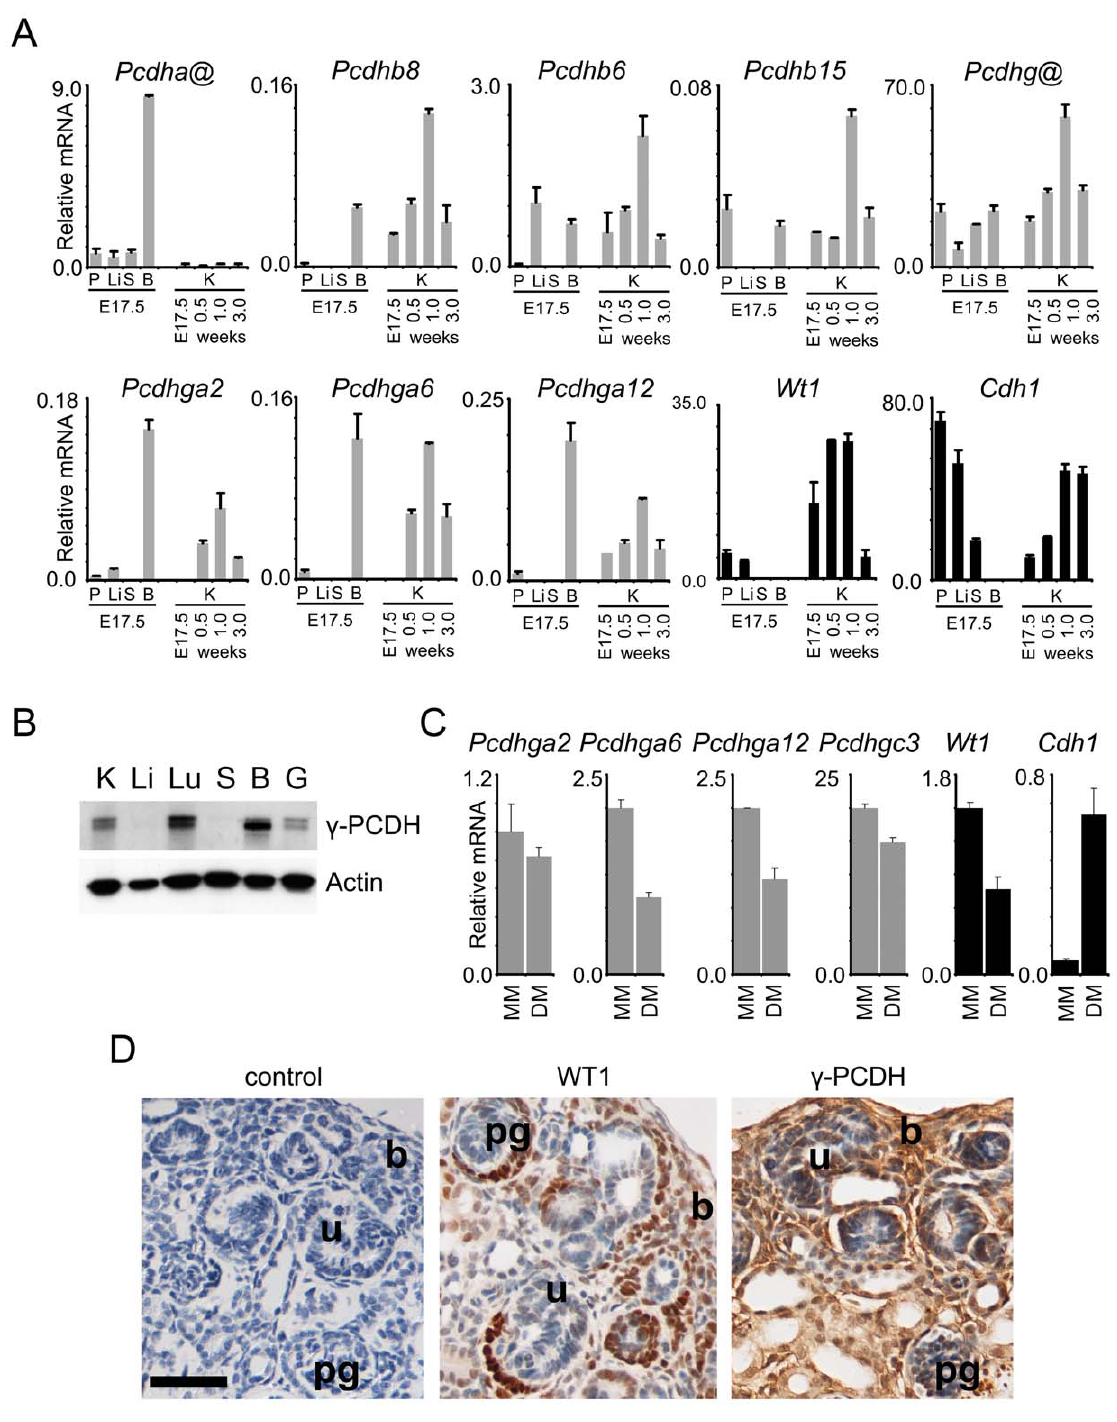
Figure 4. Developmental expression patterns of PCDHs. (A) PCDH transcript levels in mouse developmental tissues. Quantitative real-time expression analysis, relative to Tbp , in placenta (P), and E17.5 mouse fetal liver (Li), spleen (S), brain (B), and kidney (K) (E17.5, postnatal 0.5 week, 1 week, and 3 week) using assays specific for the constant region exons of Pcdha@ and Pcdhg@ , and individual Pcdh transcripts. Expression of Wt1 and Cdh1 are also shown (black bars). (B) Immunoblotting of human fetal tissue proteins with pan c -PCDH antibody or actin for loading control. Samples are kidney (K), liver (Li), lung (Lu), spleen (S), brain (B), and gut (G). (C) Gene expression changes accompanying epithelial differentiation of rat metanephric mesenchyme following Lif, Fgf2, and Tgf a treatment. Quantitative real-time expression analysis, relative to Tbp , is shown for freshly dissected rat metanephric mesenchyme (MM) and differentiating mesenchyme (DM). (D) Immunohistochemical analysis of 1-day postnatal murine kidney with antibodies towards Wt1 and c -PCDHs. Blastema (b), primitive glomeruli (pg), and ureteric buds (u) are labelled. The control panel shows a section where the primary antibody has been omitted. Bar =50 m m.